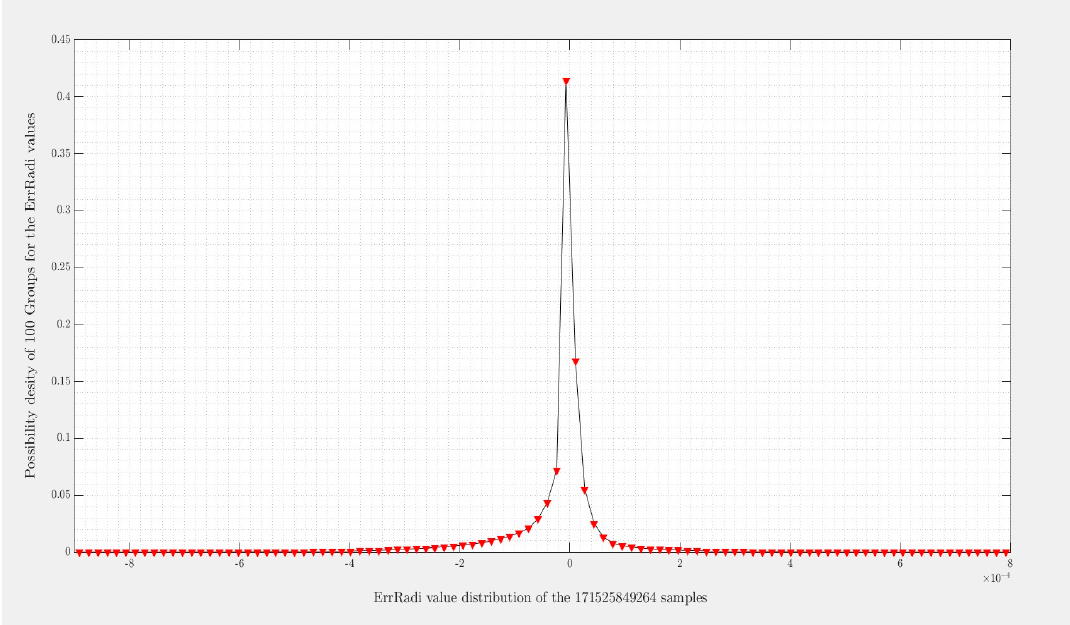
Figure 4. Distribution of the 1.7 × 10 11 samples of the radiance-bias values in channel i ( ErrRad i ) simulated within the wavelength range of [10.357,11.708] µ m under the surface temperature range of [223,334] K with twelve atmospheric transmittances and one sample of the mentioned surface spectral emissivity.